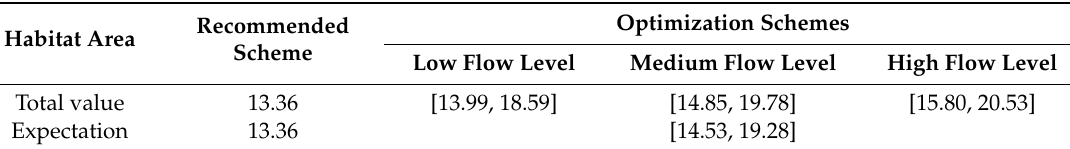
Table 6. Comparison of the habitat areas of rare and endangered water birds restored by di ff erent water replenishment schemes (in 10 3